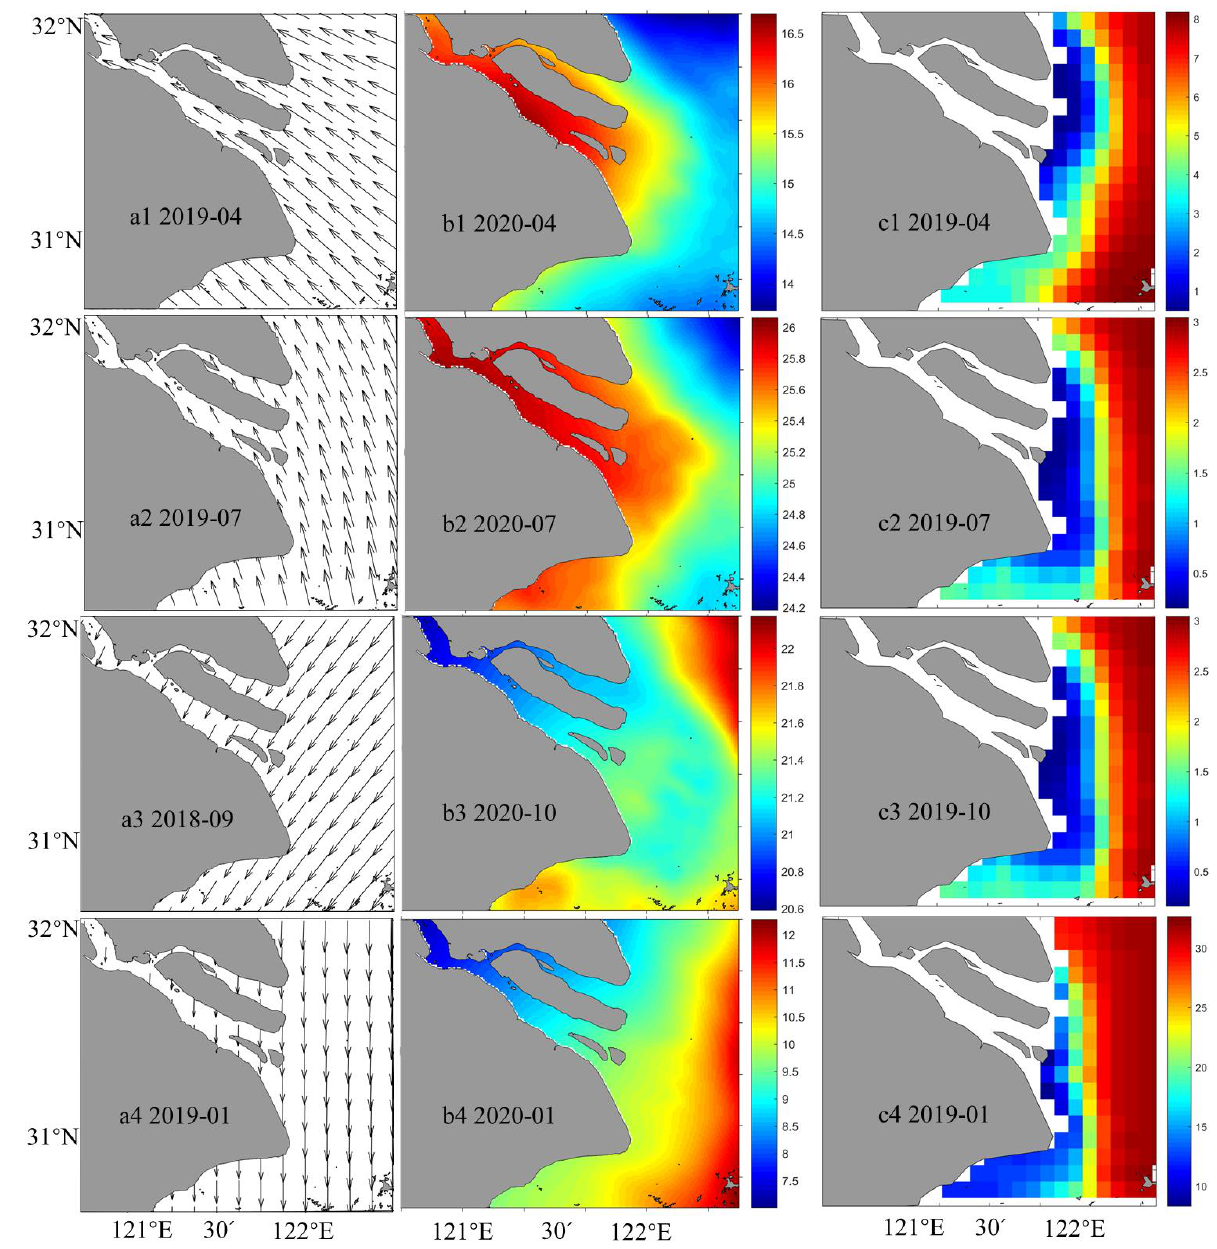
Figure 11. ( a1 – a4 ): Monthly wind field. ( b1 – b4 ): Monthly mean SST. ( c1 – c4 ): Monthly mean SSS.